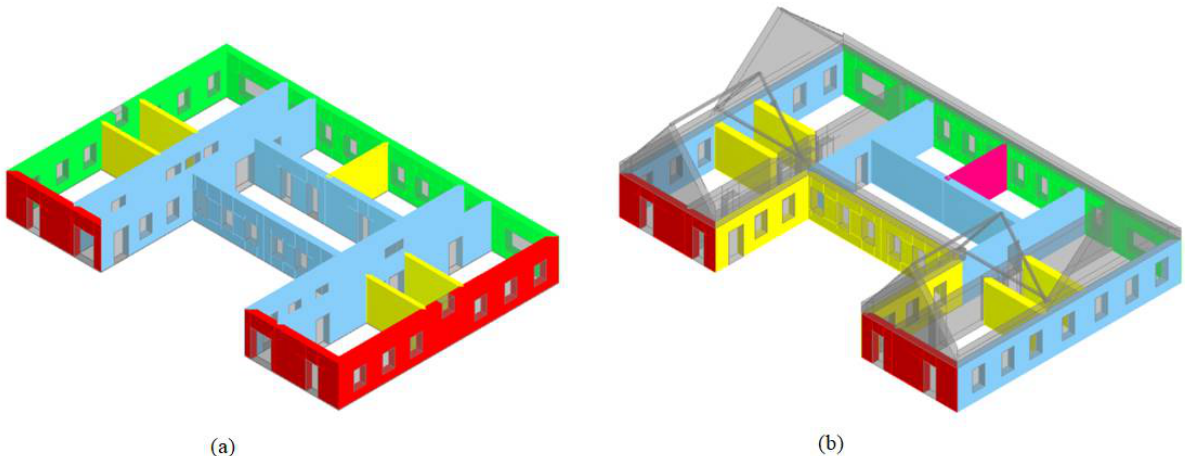
Figure 18. Configuration of different FRCM systems: ( a ) on the ground floor; ( b ) on the first floor.